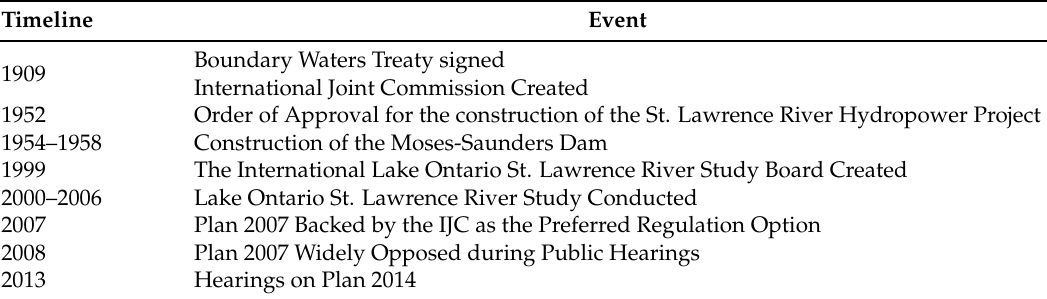
Table 1. Timeline of